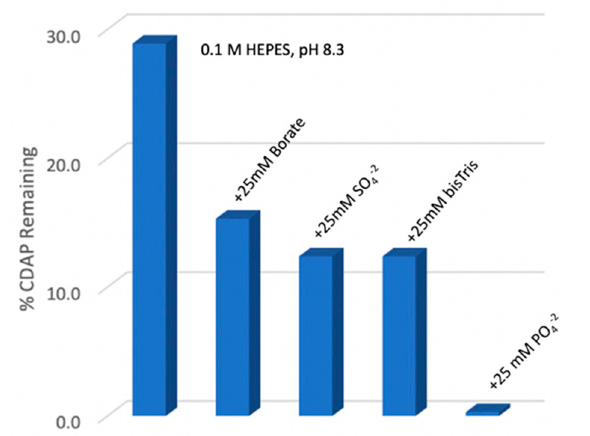
Figure 5. CDAP stability in buffers and salts. 0.1 M HEPES solutions (1 mL) containing 25 mM sodium phosphate, sodium sulfate, sodium borate, bis-Tris or no added salt, each with a final pH of 8.3 at 0 °C were prepared. 25 µL 100 mg/mL CDAP was added, and at 10 min, a 25 µL aliquot was transferred to 2 mL 0.1 M HCl. Controls for 0% and 100% hydrolysis were obtained by adding CDAP to 0.1 M HCl or 0.1 M NaOH and each were subsequently transferred to 0.1 M HCl. All samples were read at 312 nm and the % remaining CDAP was calculated.